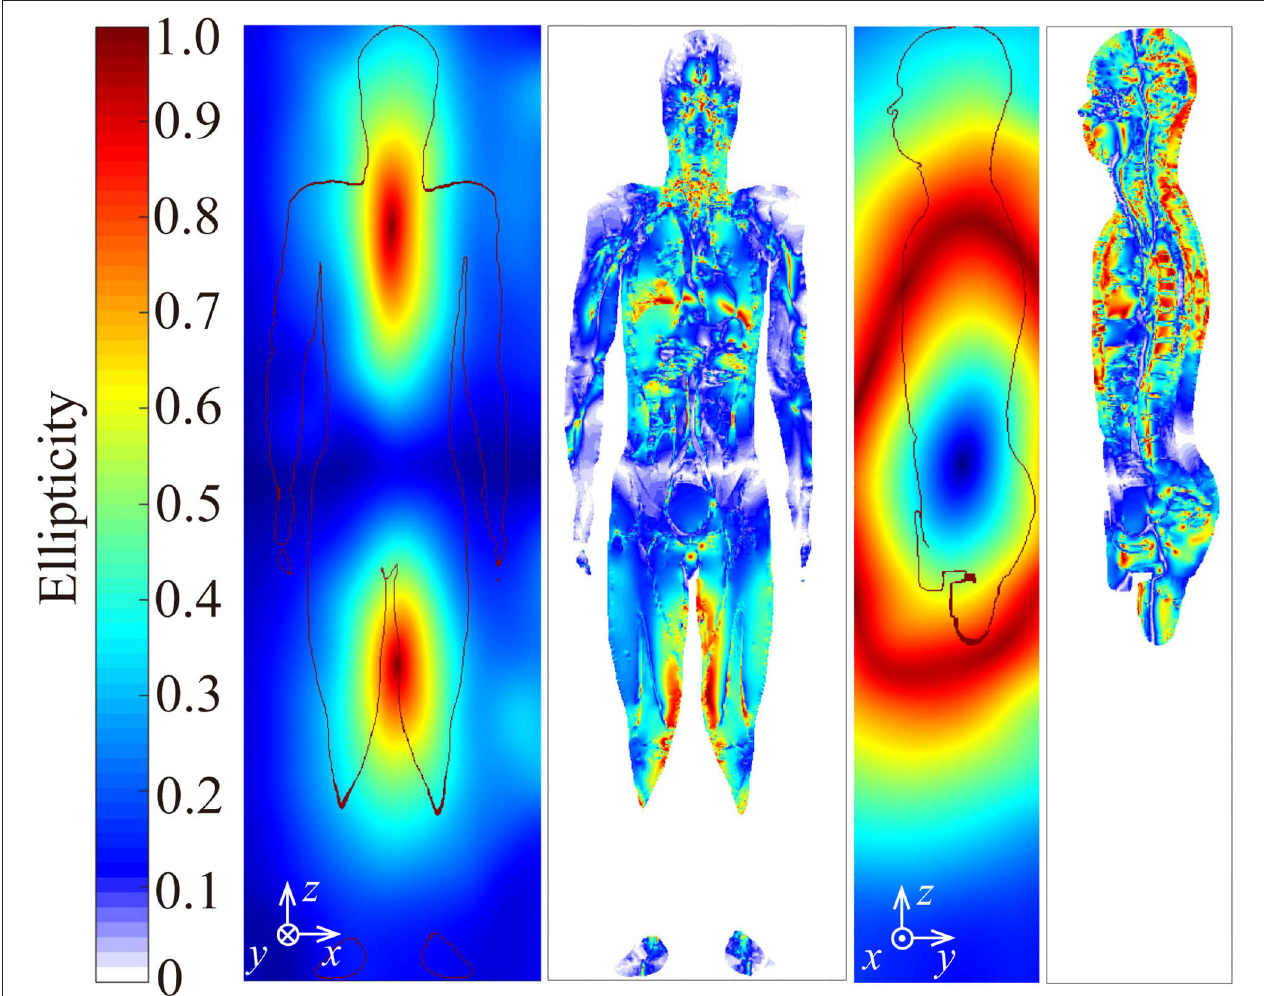
FIGURE 8 | Ellipticity of incident magnetic field (left of each) and induced electric field (right of each) on the mid-coronal section and mid-sagittal section of the human model standing in the gate aisle of